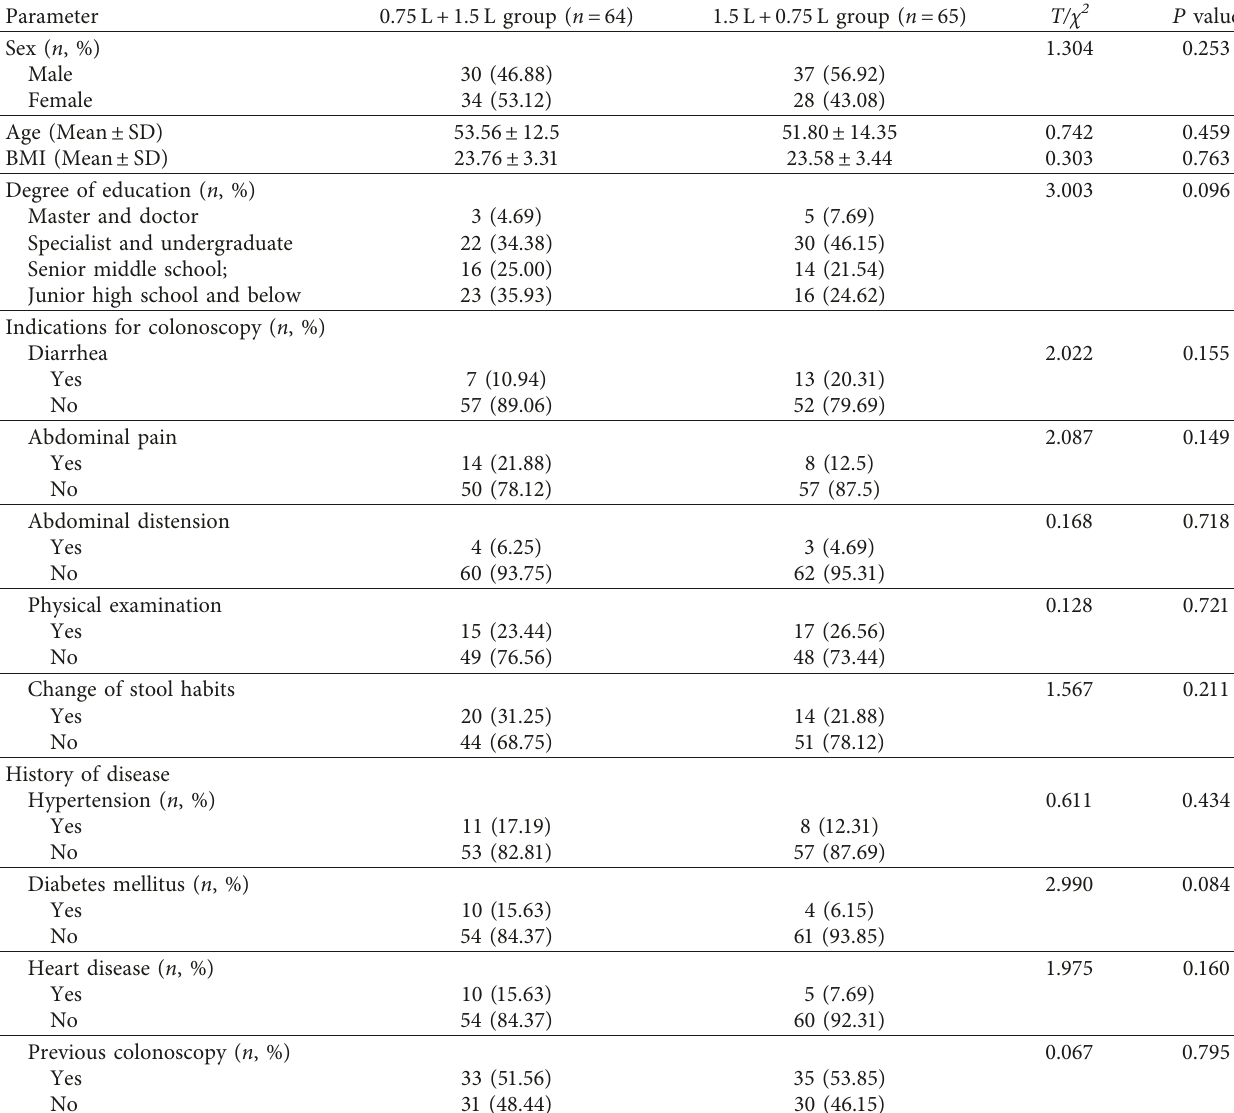
Table 1: Patient demographic data and clinical characteristics for colonoscopy.